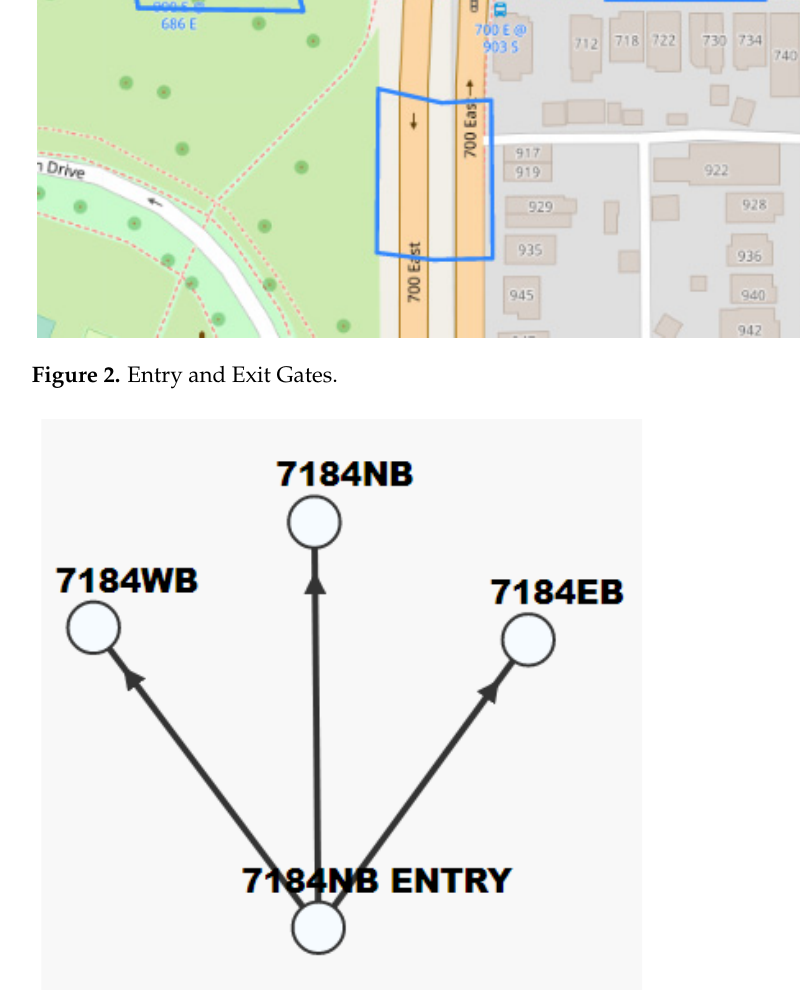
Figure 4. Turning Movement from DB4IoT. 2.4. Methodology This study provides a method that uses CV data to estimate TM rates at intersections in a low-penetration CV environment. These estimated TM rates can then be applied to actual traffic counts derived from detector data to produce TM counts. This solution is not expensive since it does not require the installation of any hardware at the intersection, unlike many earlier attempts. It also functions for all intersection geometries, with or with- out shared lanes, and for intersections instrumented with any type of traffic detection sys- tem. The TM percentages obtained from the CV data alone will likely not represent the turning behavior of all traffic flowing through the intersection because of the low